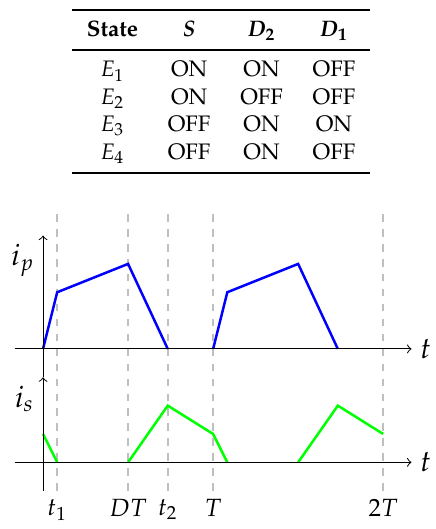
Table 1. States of the Period-1 orbit.